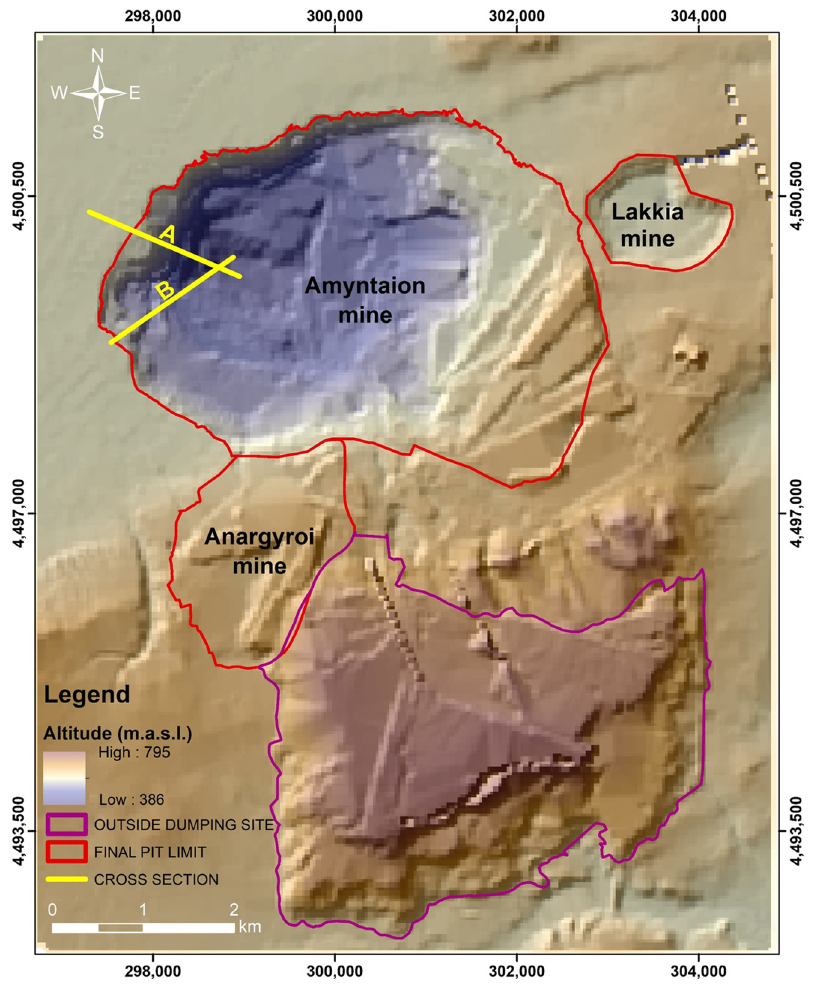
Figure 3. Digital Elevation Model (December 2021) of the Amyntaion mining area, showing the three main mines (Anargyroi, Amyntaion and Lakkia). Elevations are shown in hillshade effect.